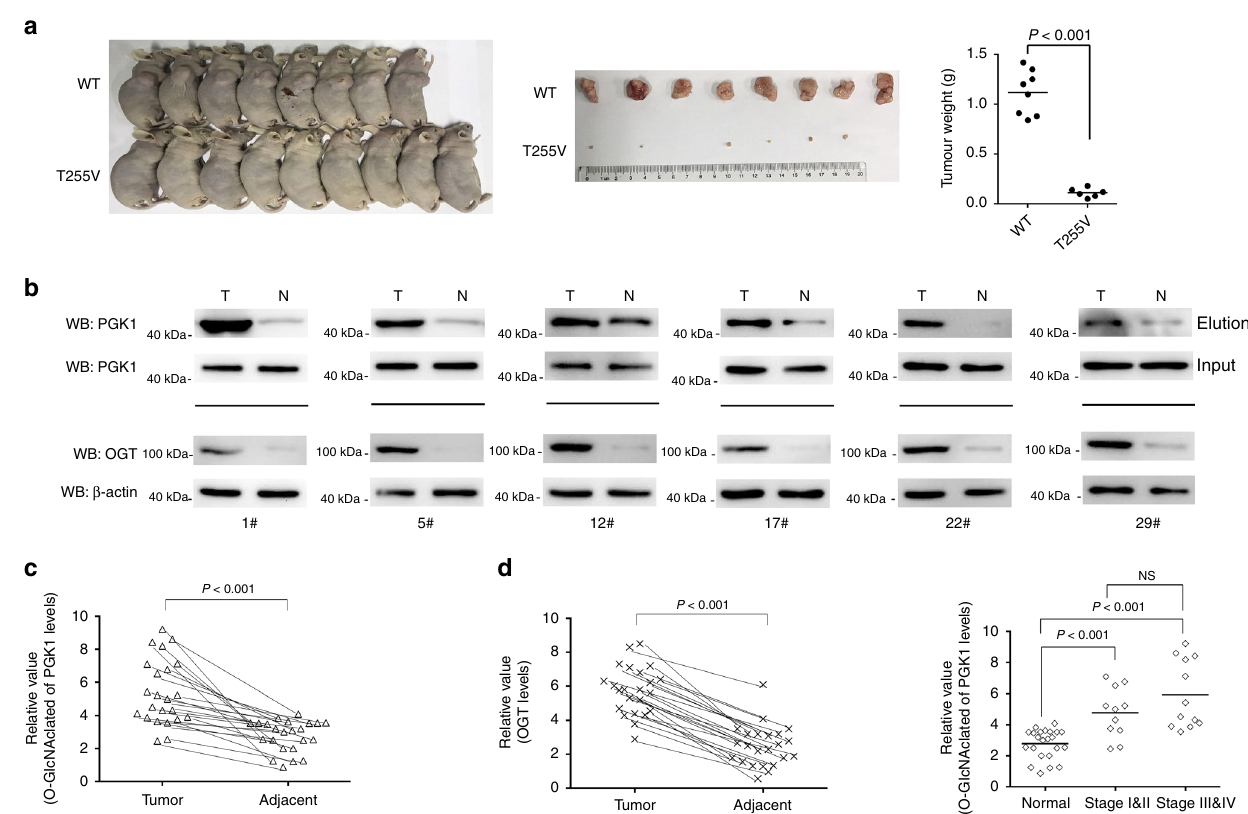
Fig. 8 T255 O-GlcNAcylation of PGK1 promotes tumor formation and increases in colon tumor tissues. a Tumor formation in nude mice injected with PGK1 WT or T255V rescue HT-29 cells. Dissected tumors at the experimental endpoint were shown, and the masses of the dissected tumors were weighted. b Immunoblotting analysis of PGK1 glycosylation and OGT expression in human colon tumor (T) tissues and the matching adjacent tissues (N). c – e The statistical analysis of paired tumor and matching adjacent tissues. Relative PGK1 glycosylation level was normalized to the total PGK1 protein level for each patient. Source data are provided as a Source Date fi le.